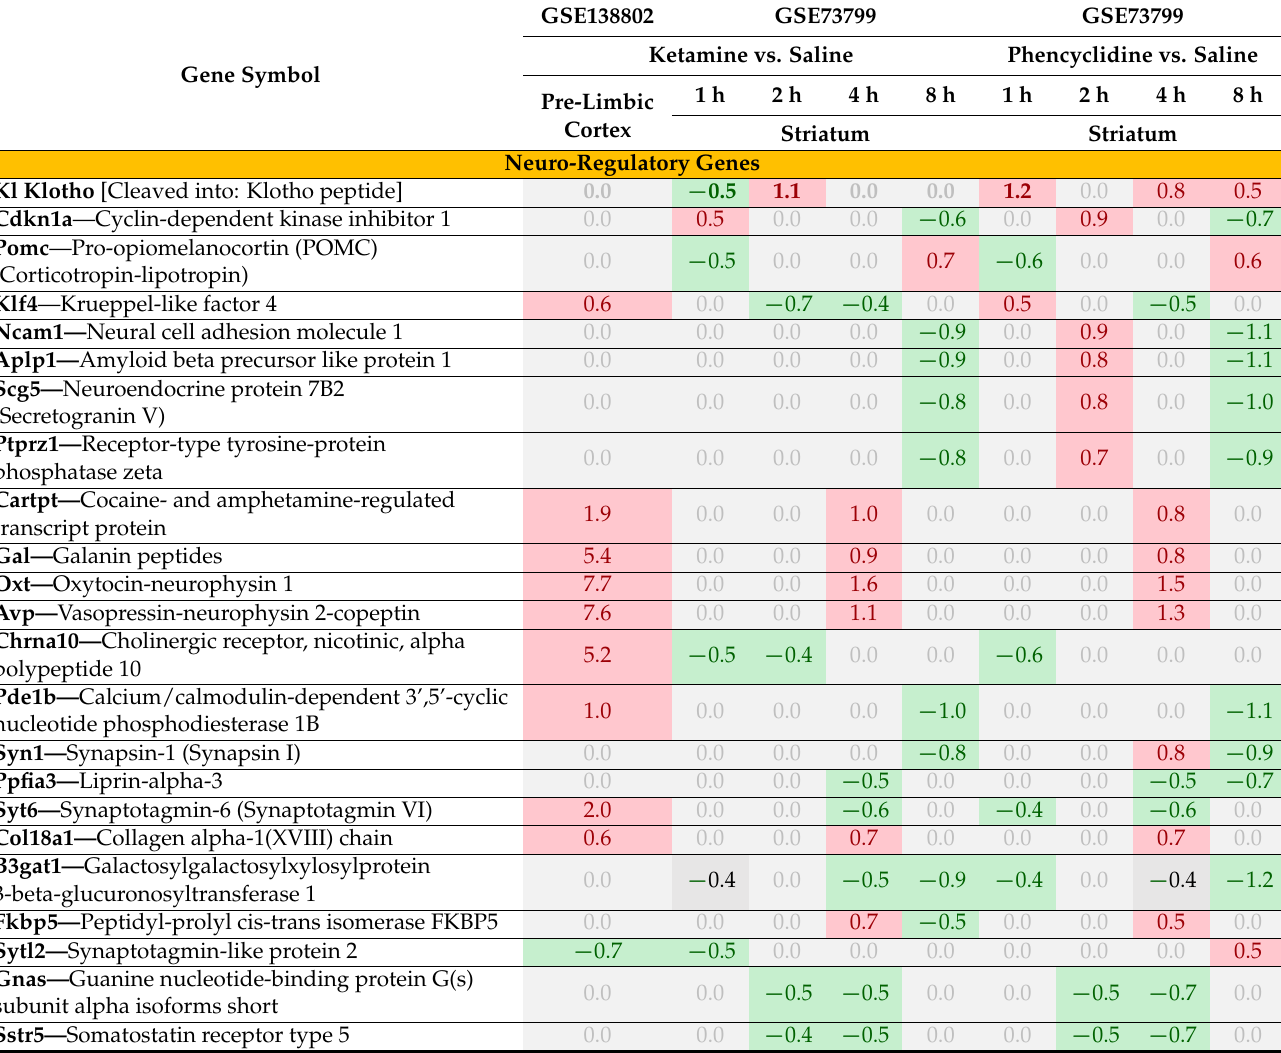
Table 2. Molecular function of neuro-regulatory and glycogene DEGs in response to ketamine and phencyclidine treatment. The table captures the selected DEGs that are 0.5 log fold differentially regulated (light, green-coloured boxes representing the down-regulated genes and the light, red- coloured boxes for the up-regulated genes). Only those data points that have significant representation of the neuro-regulatory and glycogene DEGs are selected for making the table with only including the genes that match the fold change filter criteria and are represented in at least 3 out of the 9 selected data points. For the full list of the DEGs refer Supplementary Tables S6 and